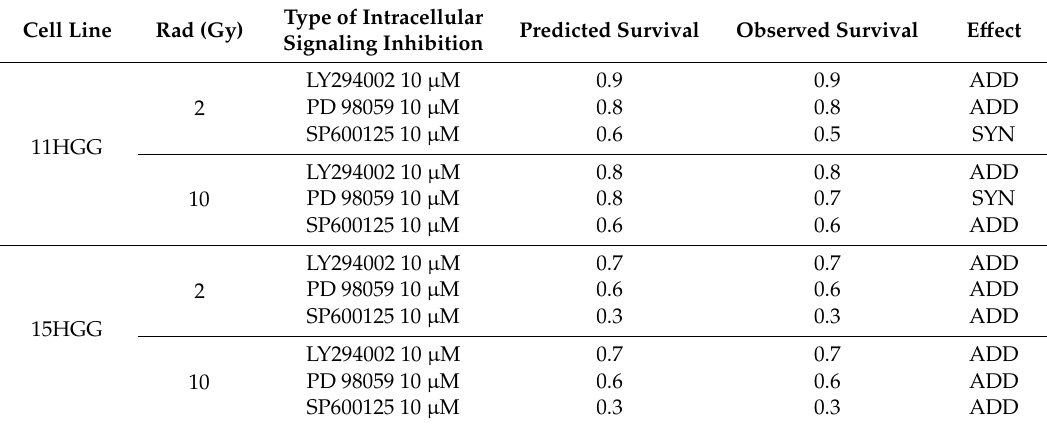
Table 3. Observed e ff ects for cell lines 11 and 15